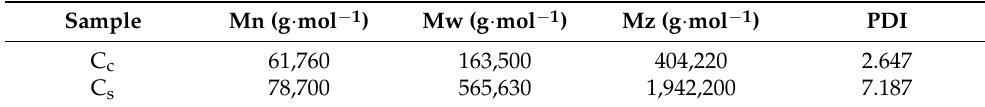
Table 1. The result of size exclusion chromatography of cellulose powders C c and C s . C s has a higher molecular weight and polymer dispersity index (PDI).